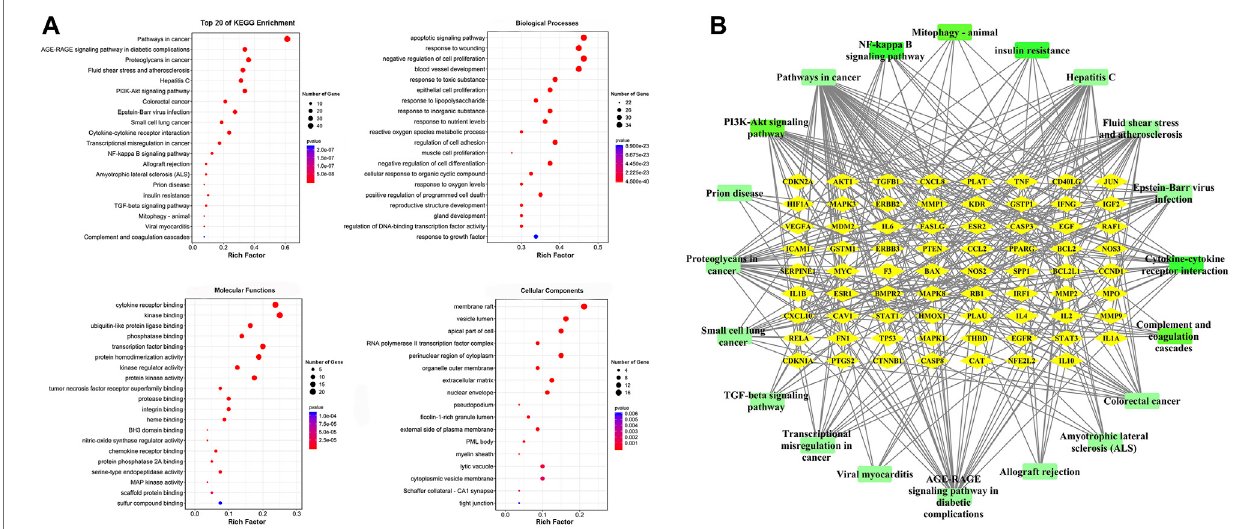
FIGURE2| GOenrichmentofthe80commongenes. (A) Abubblechartoftop20GOenrichmentterms.Theredderthebubble,thesmallerthe p -value;thebigger the bubble, the greater the number of genes participated in this pathway. (B) PPI network of the top 20 KEGG signaling pathways and associated target genes. Green nodes represent top 20 KEGG pathways and yellow nodes indicate the genes participated. Among them, PI3K-Akt signaling pathway, NF-kappa B signaling pathway, Mitophagy-animal, Complement and coagulation cascades, Cytokine-cytokine receptor interaction, and TGF-beta signaling pathway were closely related to ALI